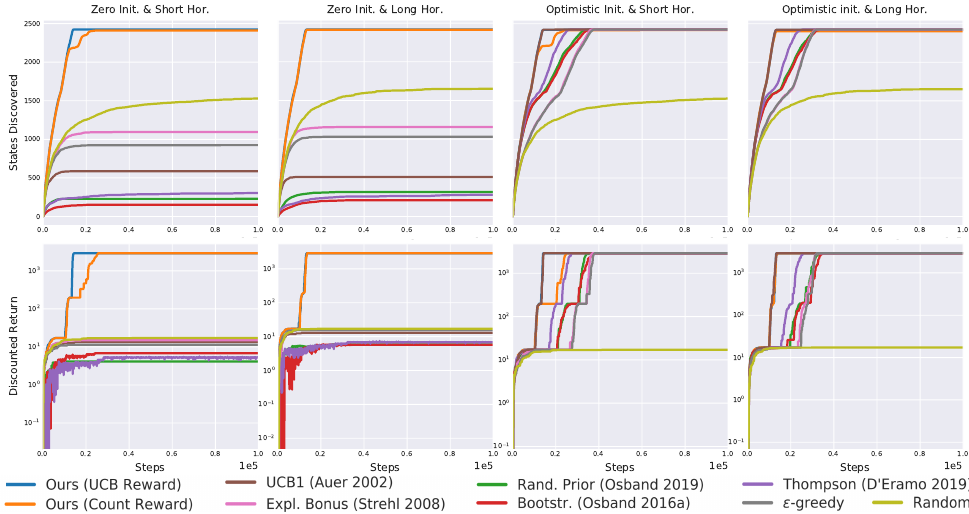
Figure 18. The final gridworld emphasizes the better performance of our